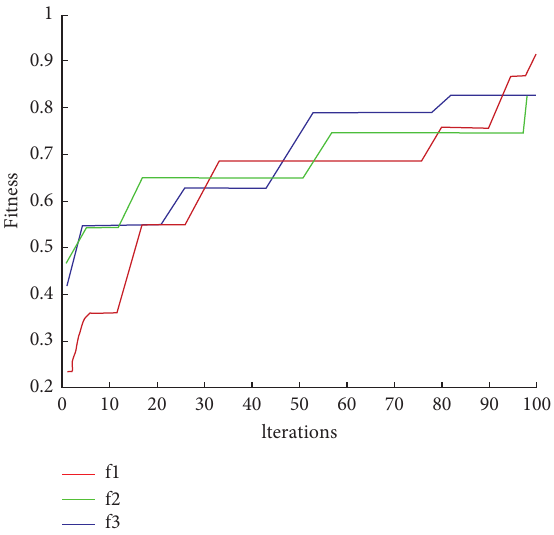
Figure 8: Performances of fitness vs iterations. Table 4: Production function value for 100